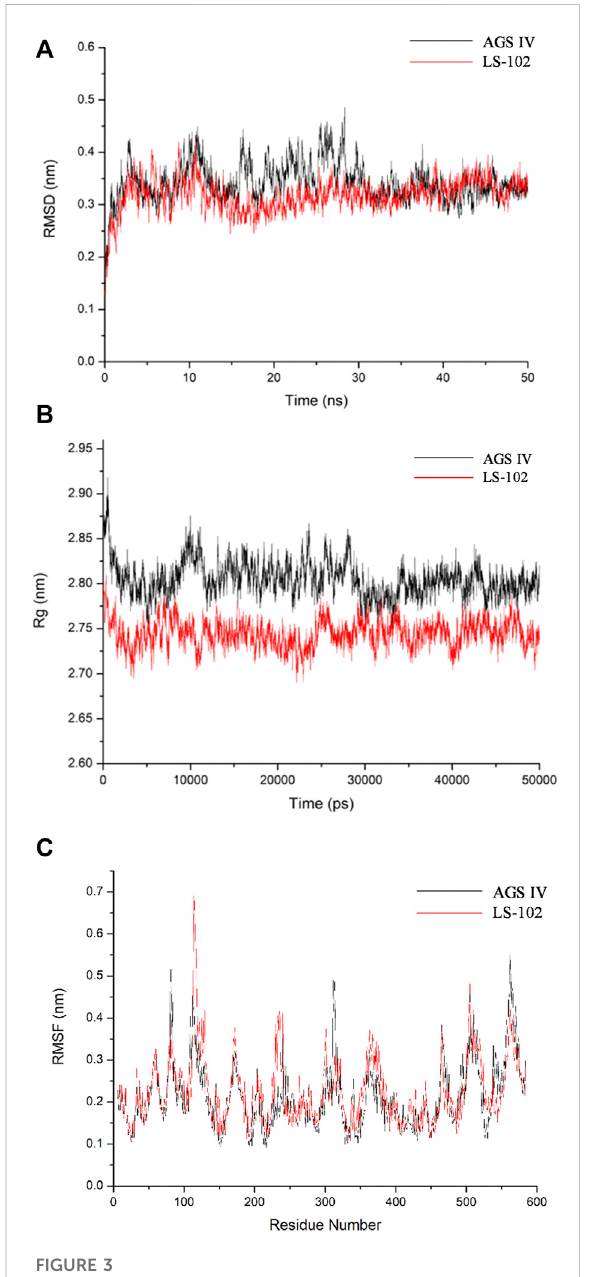
FIGURE 3 Molecular dynamics simulation of HSA – ligand complex for 50 ns time scale (A) Root-mean-square deviation (RMSD) of C α - atoms for HSA-AGS IV/LS102 complex. (B) Radius of gyration values for HSA present in systems. (C) RMSF values of HSA/ AGS IV and HSA/LS-102 complex were plotted against residue numbers.